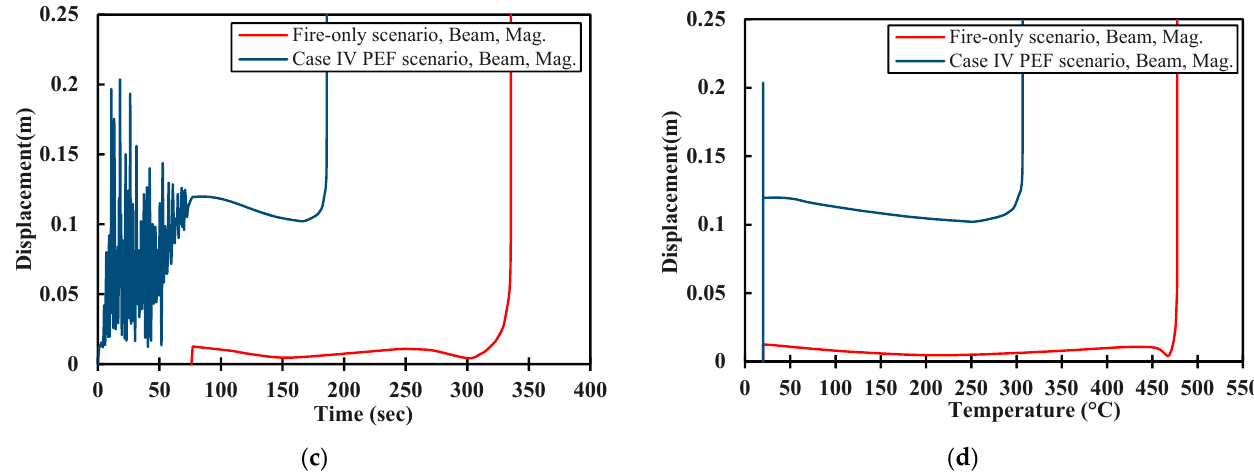
Figure 18. Comparison of the fire-only analysis versus the PEF analysis for Case IV including ( a ) the time-mid-span displacement record in the y-direction, ( b ) the time-mid-span displacement record in the z-direction, ( c ) the time-mid-span displacement record for the total displacement and ( d ) the temperature-mid-span displacement record for the total displacement.